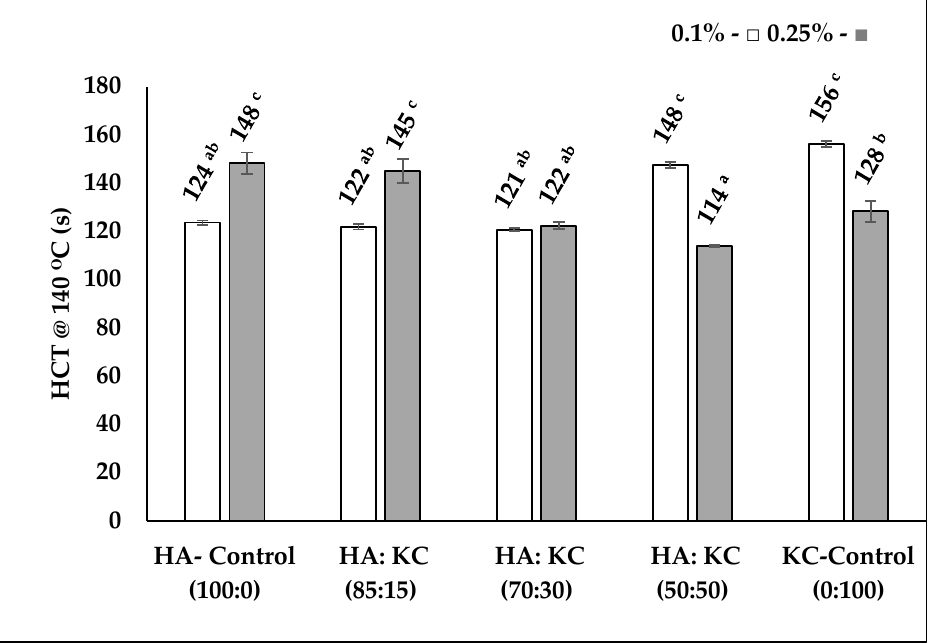
Figure 5. HCT at 140 °C of skim milk sample as a function of two different concentrations of 0.1% ( □ ) and 0.25% ( ■ ), and different ratios of HA + KC: The error bars represent the standard deviation of the mean for each treatment’s triple analysis. Significant differences between ( p < 0.05) HCT values on the column bar are shown by completely different superscript letters a–c .